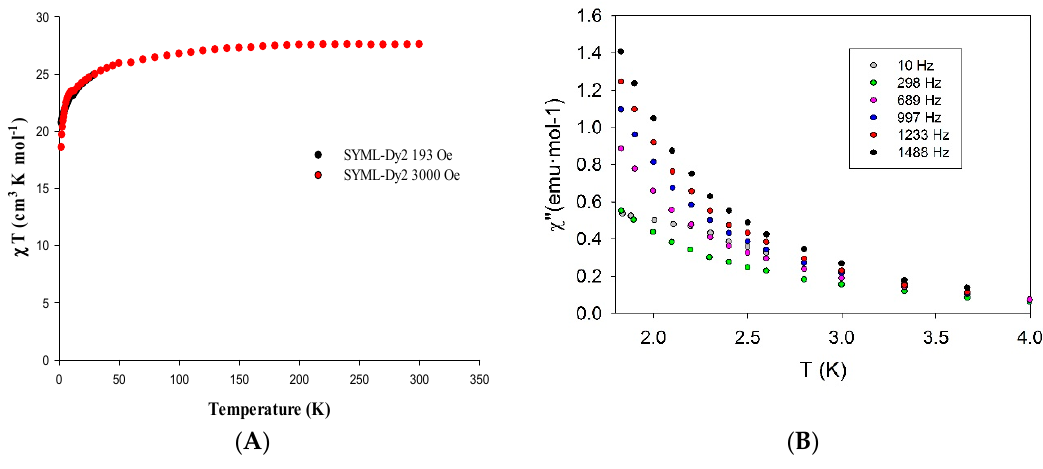
Figure 2. ( A ) Magnetic susceptibility plot for SYML-Dy2. ( B ) Out-of-phase alternate current (AC) magnetic susceptibility for SYML-Dy2, with an applied direct current (DC) field of 2000 Oe.